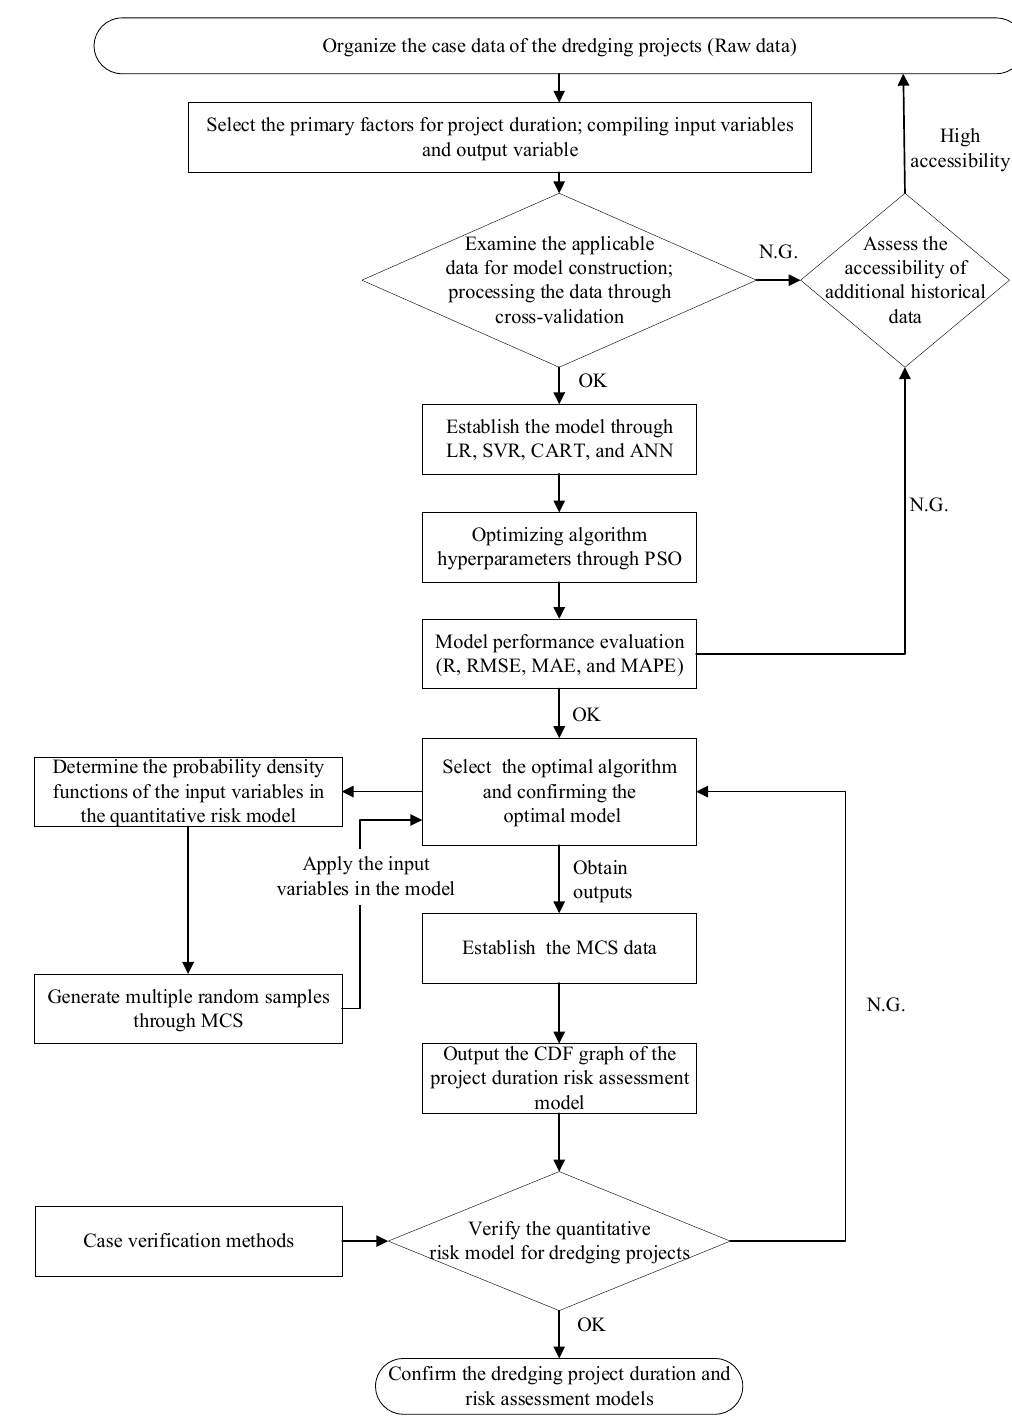
Figure 3. Machine learning in conjunction with the Monte Carlo simulation.